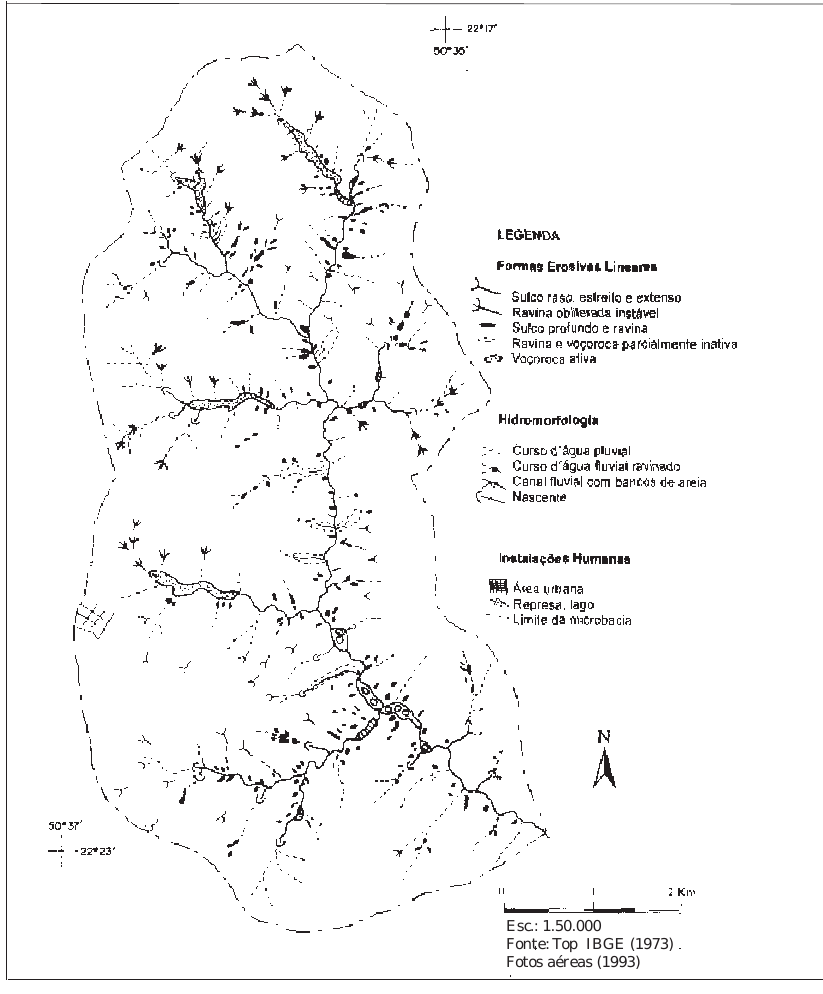
Figura 3. Levantamento da erosão linear na microbacia do ribeirão Água da Cachoeira